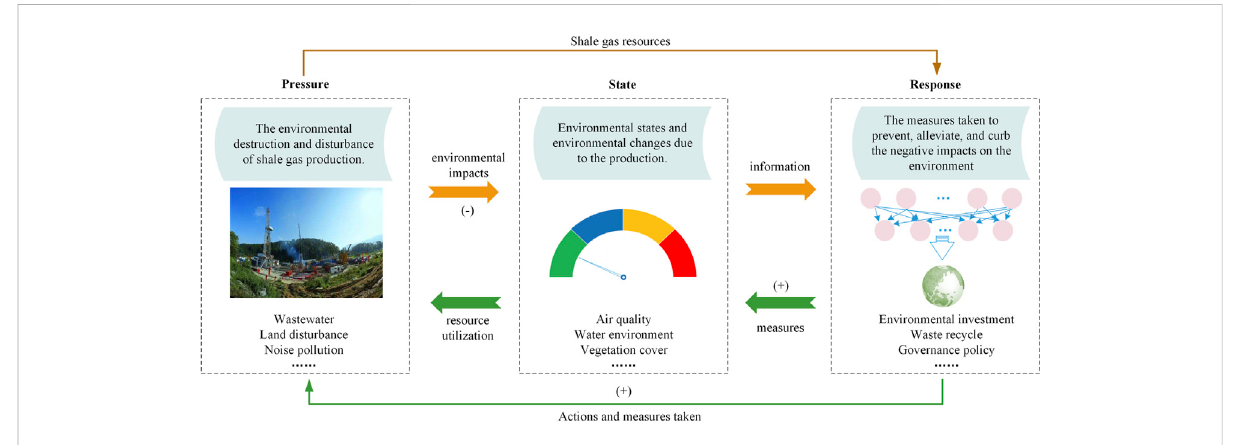
FIGURE 2 The PSR framework for forecasting the environmental status of shale gas